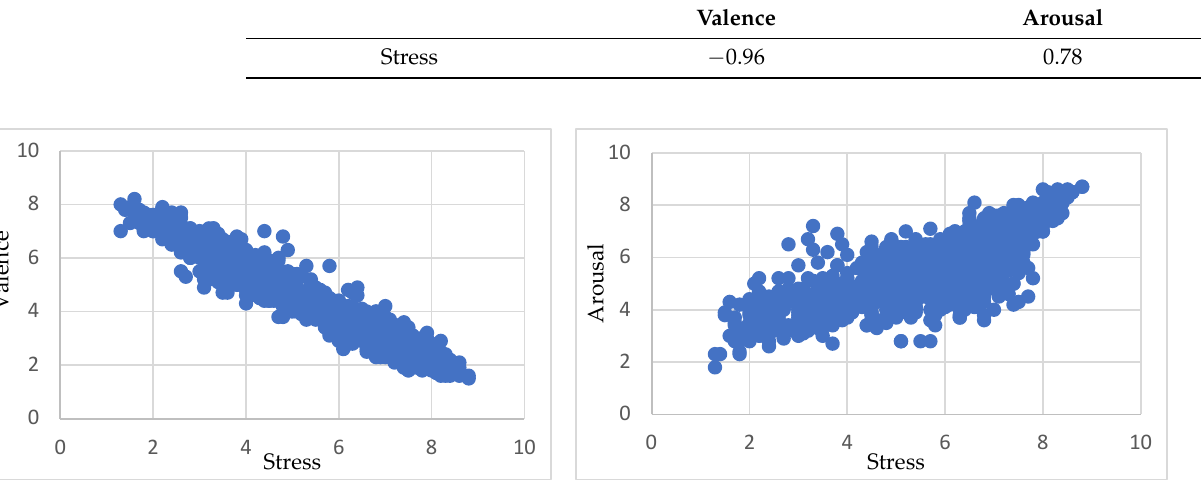
Figure 6. Correlation of each pair of values.